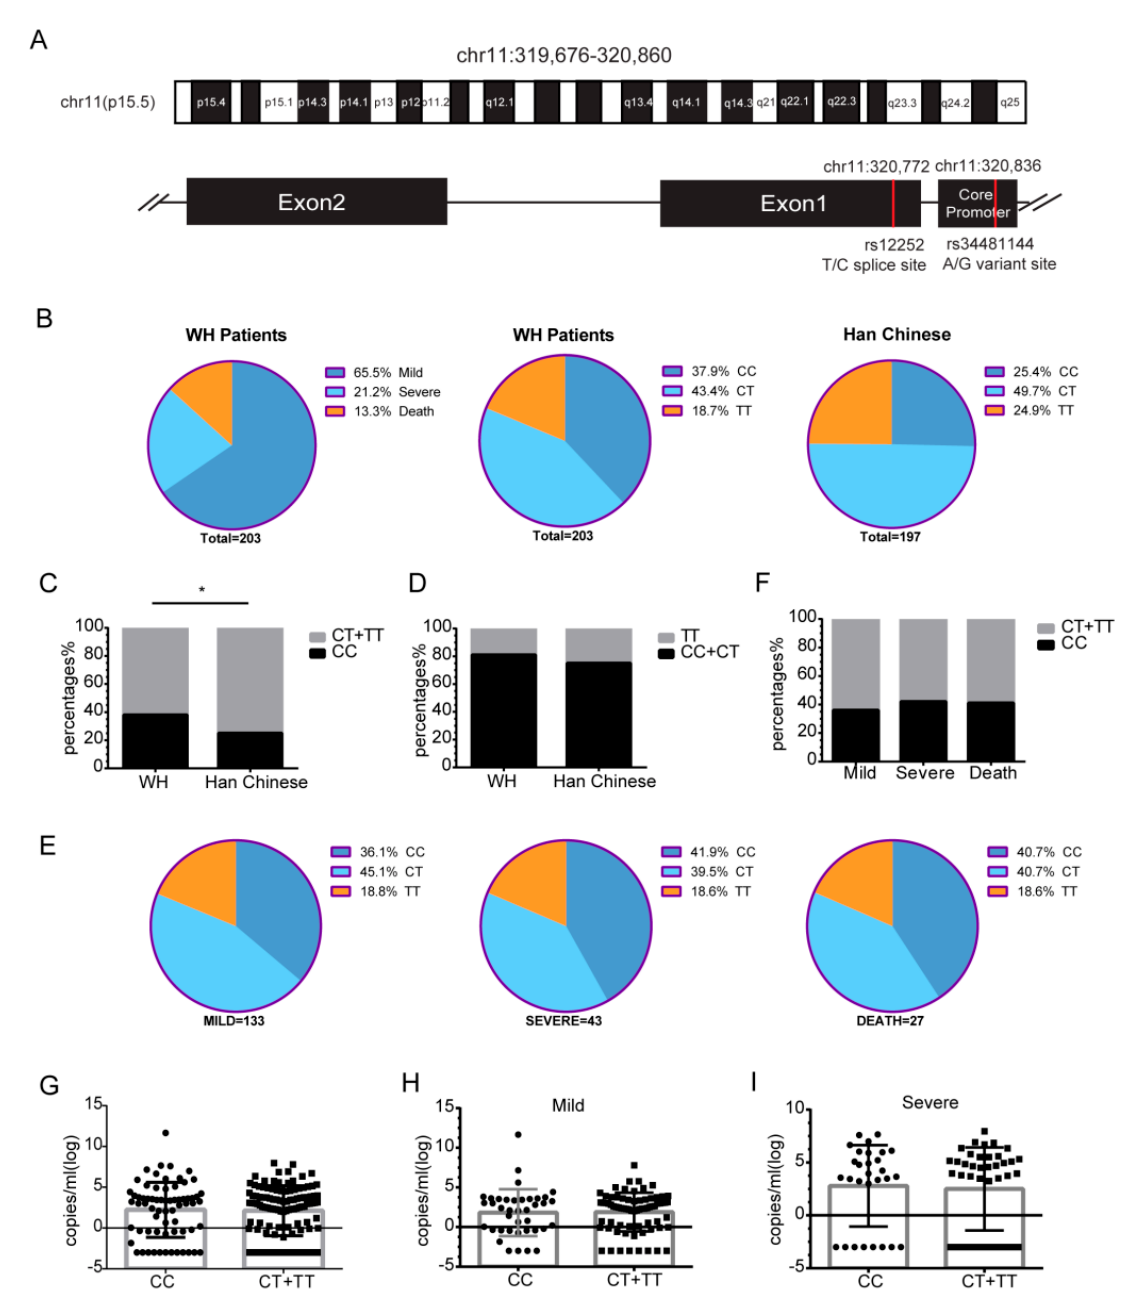
Figure 4. The rs12252 CC genotype of IFITM3 is associated with the risk of SARS-CoV-2 infection. ( A ) Illustration of SNPs rs12252 and rs34481144 of IFITM3. ( B ) Frequency of rs12252 alleles in our 203 COVID-19 patient cohort (WH patients), including 133 mild cases (65.5%), 43 severe cases (21.2%), and 27 deaths (13.3%). Han Chinese: healthy Chinese Han population (from the 1000 genome project). ( C ) The frequency of the CC genotype (37.9%) was increased ( p = 0.04) in our COVID-19 patient cohort. ( D ) Frequency of the rs12252-C allele in our cohort and in the Chinese Han population (data from the 1000 genomes project). ( E ) Frequencies of the rs12252 alleles in mild, severe, and death cases. ( F ) Frequency of the CC genotype in mild, severe, and death cases. ( G ) Viral load in the throat swab samples from the CC and CT/TT carriers. ( H , I ) Viral load in the CC and CT/TT carriers from the mild group ( H ) and the severe group ( I ). WH patients, Wuhan patients; *, p < 0.05.